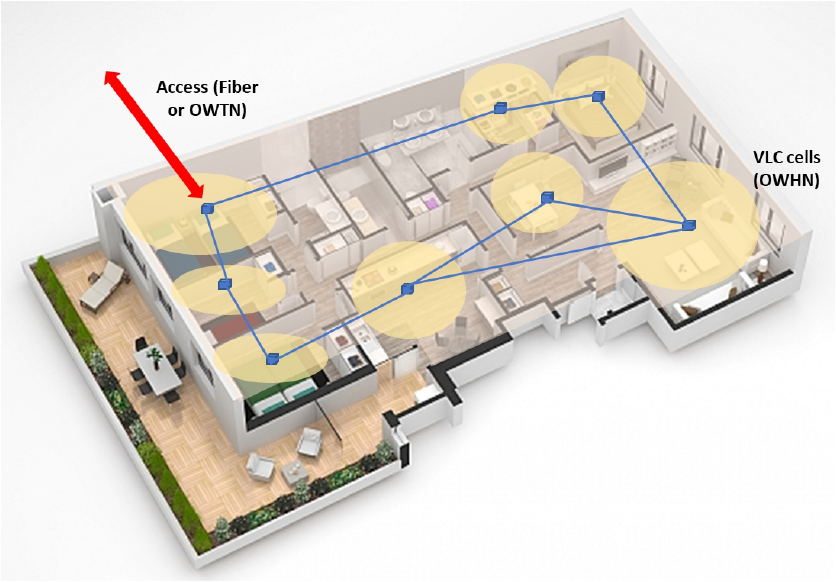
Figure 4. Optical wireless data